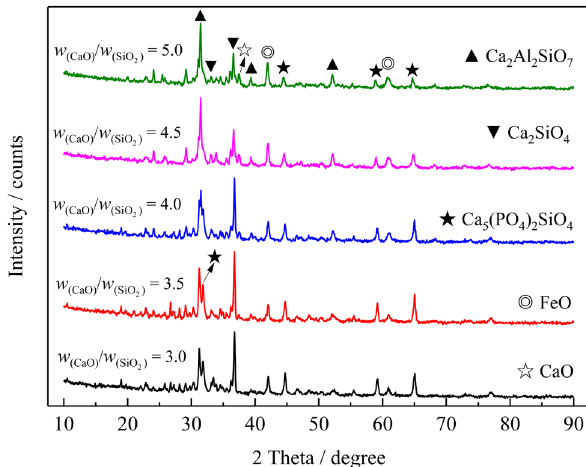
Figure 5: XRD patterns of the high - P - containing slag at di ff erent basicities.